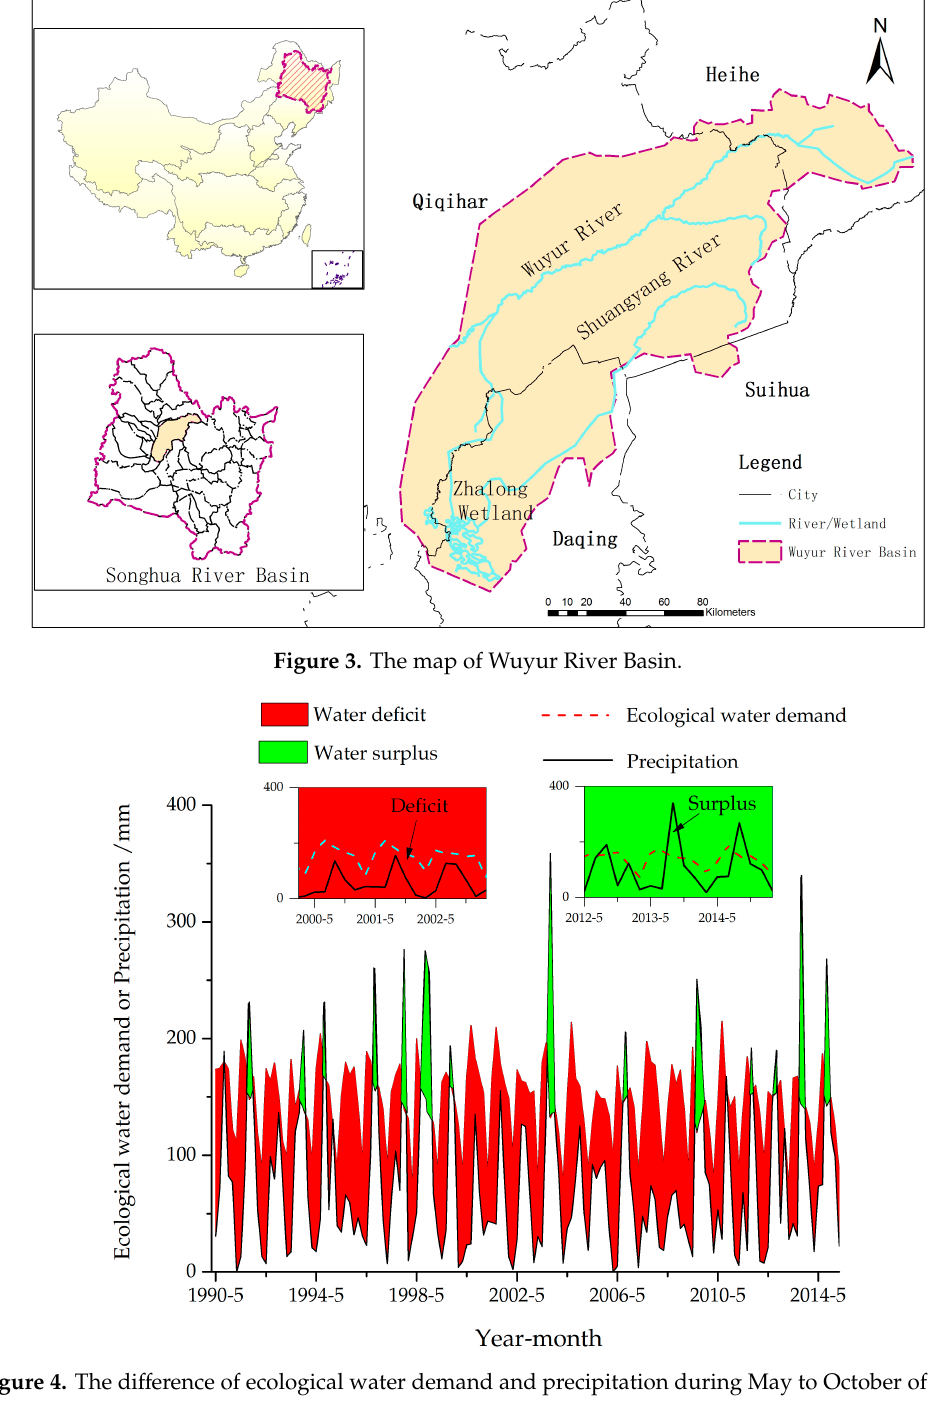
Figure 4. The difference of ecological water demand and precipitation during May to October of each year from 1990.